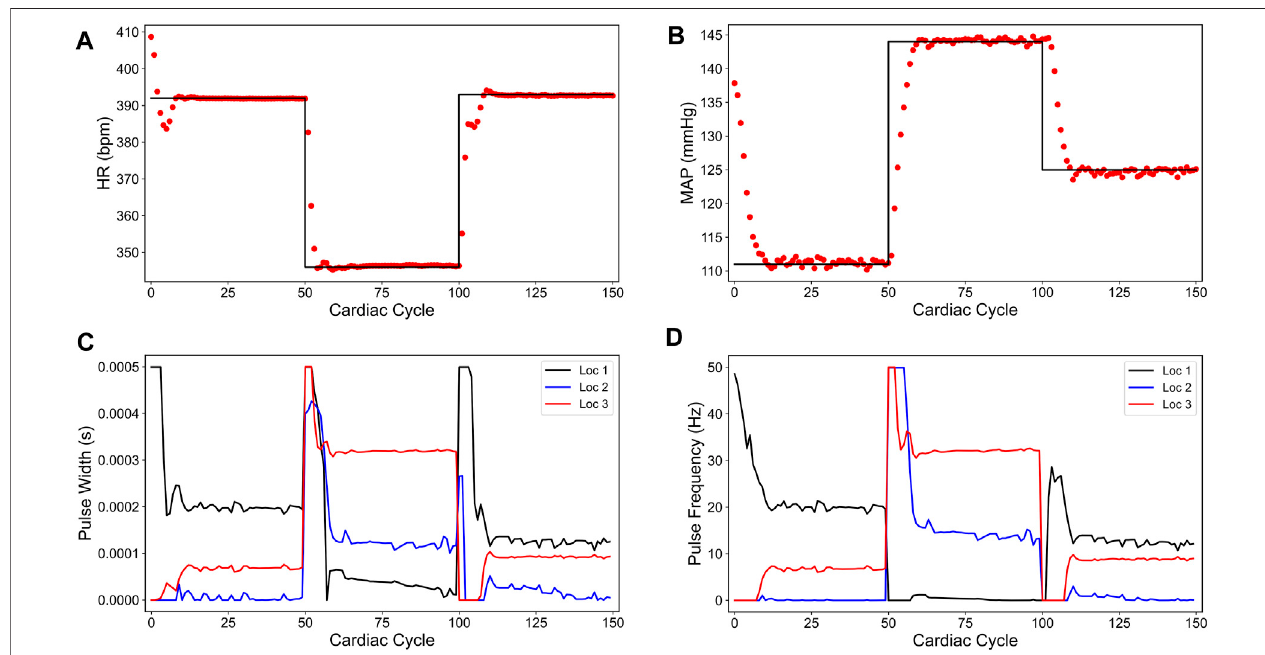
FIGURE4| Minimumenergy-based closed-loop control oftheheartrate (HR) and themean arterial blood pressure (MAP)ofthe insilico physiologicalmodel ofthe rat cardiac system. (A) and (B) show the closed-loop control response from the in silico physiological model (shown in red dots) and the target (or reference) for the controller (shown in black line) for HR and MAP, respectively. (C) and (D) show the pulse width and the stimulation frequency, respectively, designed by the controller at each VNS location.